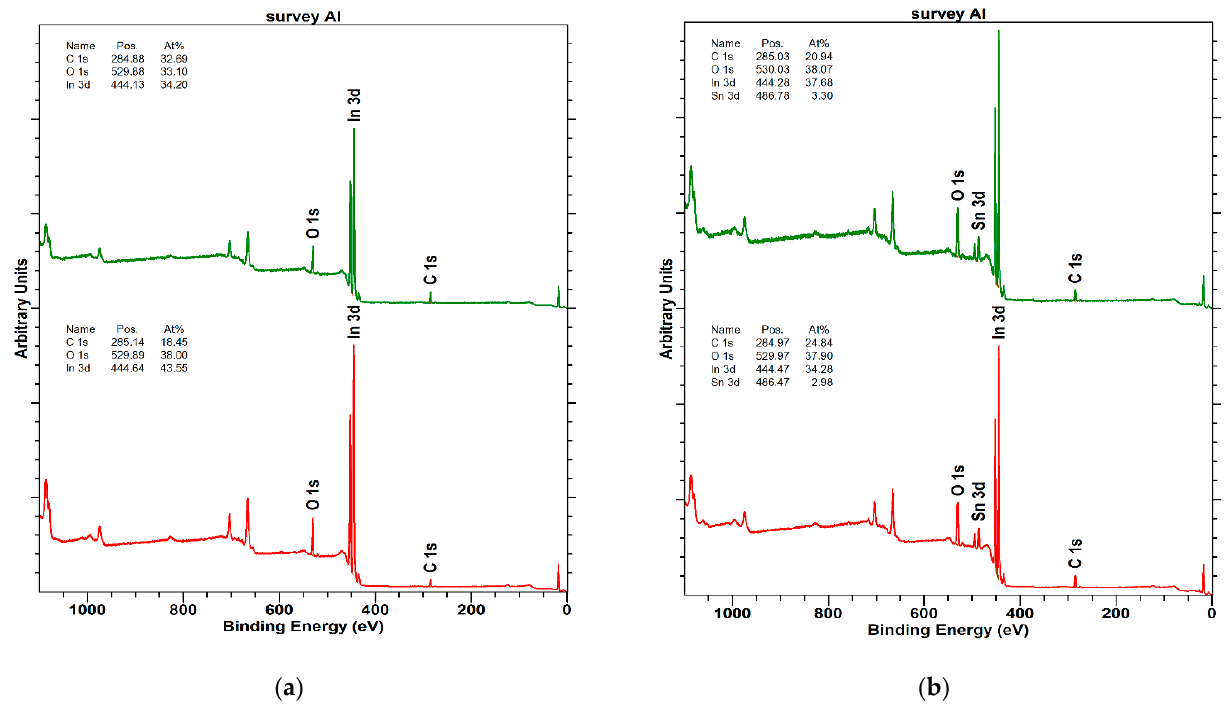
Figure 3. Survey spectra of ( a ) In 2 O 3 , ( b ) ITO sample surfaces (where: at the bottom − 25 nm, at the top 135 nm). Table 5. The results of survey spectra of In 2 O 3 and ITO sample surfaces samples.